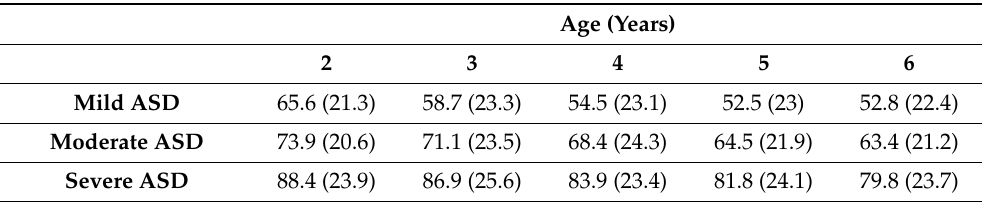
Table 7. Averaged Total ATEC score for the mild, moderate, and severe ASD groups. A lower score indicates symptom improvement. The data are presented as the mean